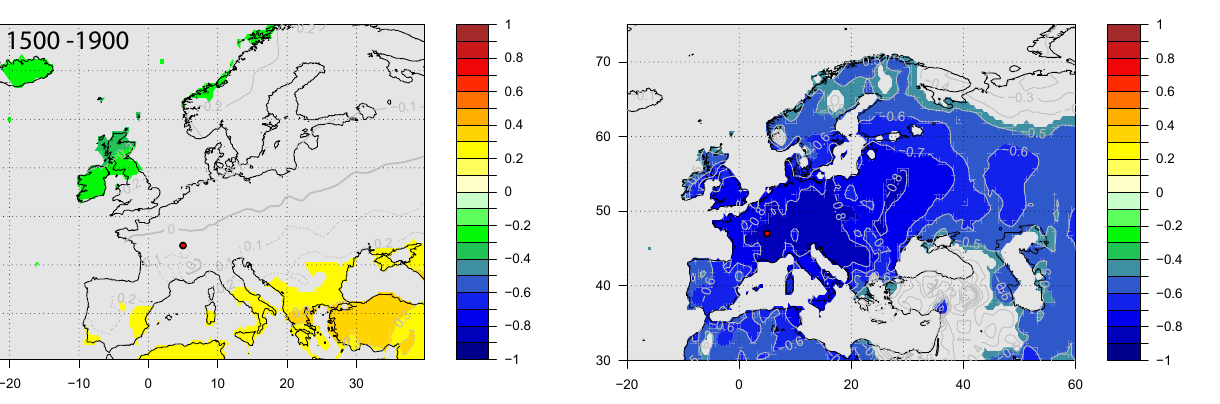
Fig. 6. Correlation of the GHD with the December-to-August near- surface temperature from CRU (1901–2002). All data were low- pass filtered using a 1/10 year cutoff. Areas of significant correla- tion are coloured ( p <